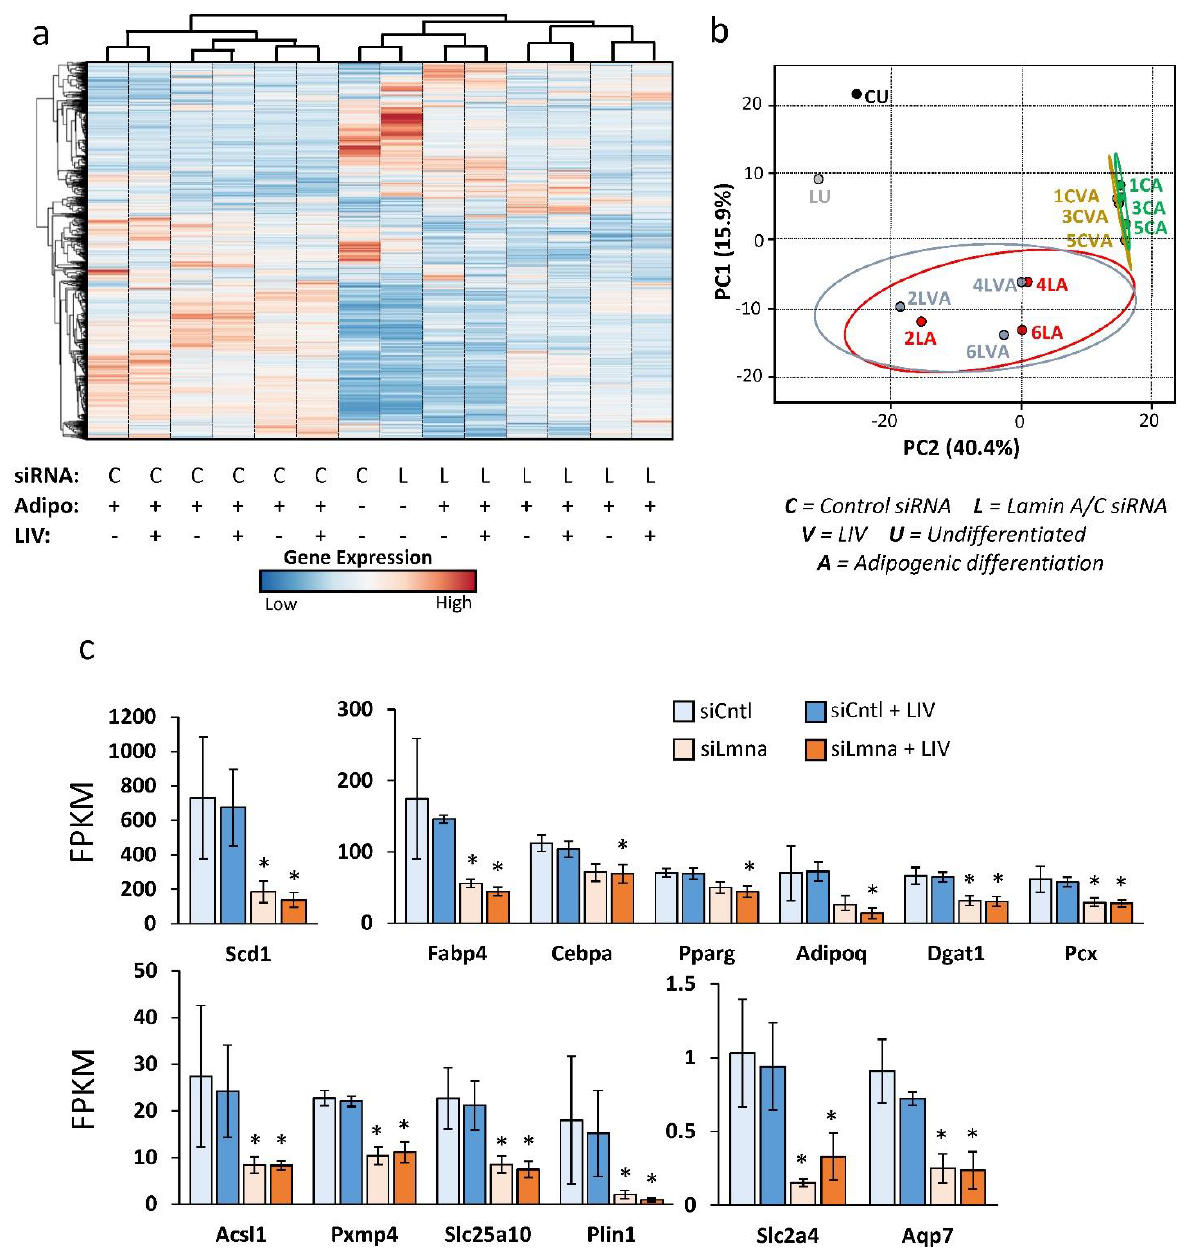
Figure 5. Differential effect of lamin A/C depletion and LIV on mRNA transcription during adipogenic differentiation: ( a ) Heat map of genes with average minimal expression of 0.3 FPKM, t -test p < 0.05, and fold change greater than 1.4. Unit variance scaling is applied to rows. ( b ) Principle component plot where principal component 1 and principal component 2 that explain 40.4% and 15.9% of the total variance, respectively. Prediction ellipses are such that with probability 0.95, a new observation from the same group will fall inside the ellipse. n = 14 data points. ( c ) Average FPKM values of DESEQ2 analysis for differentially expressed genes related to adipogenic phenotype. Results are presented as mean ± STE. * p < 0.05 and fold change > 1.0 compared to siCntl.